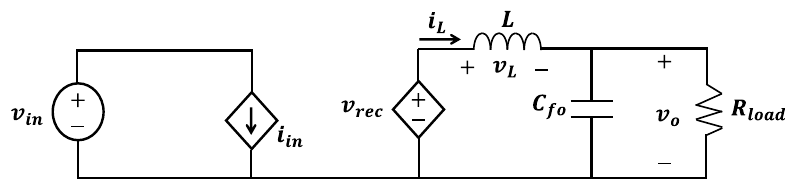
Figure 4. Averaged model of the PSFB converter. Replacing Equation (10) into Equation (7), the average rectified voltage as function of the duty ratio, d , input voltage, v in , output voltage, v o , and output inductor